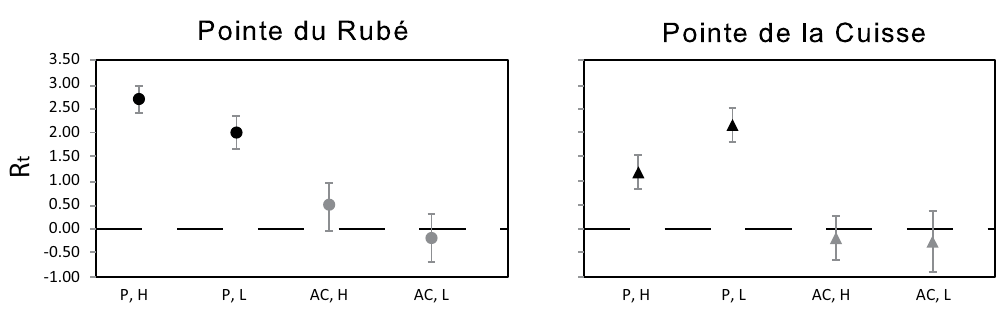
Figure 6. Effect sizes of protection and zones based on the net growth potential. Protection (P: protected, AC: artefact control), Zones (H: High, L: Low). Effect sizes are significant if confidence intervals do not overlap zero. R t : log-response ratio for each